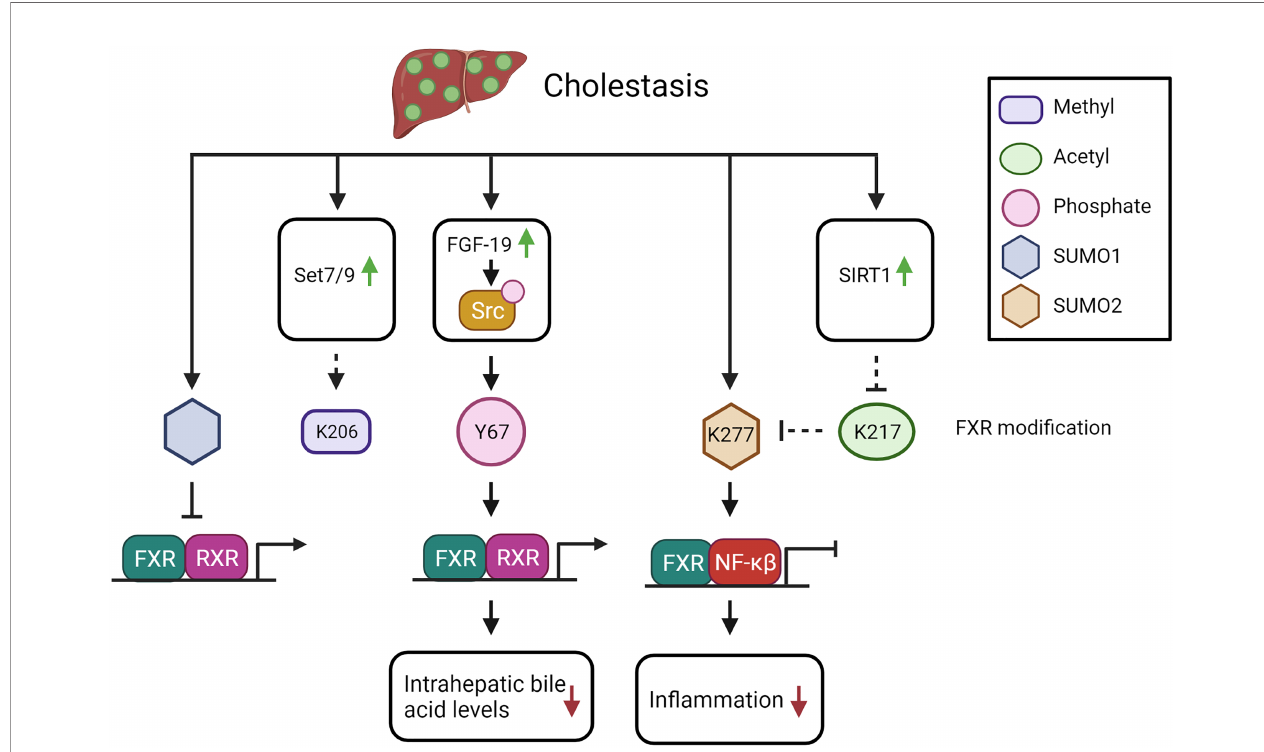
FIGURE 2 | The potential impact of FXR PTMs in cholestasis (see text for explanation). Solid arrows indicate demonstrated relations or interactions, dashed lines indicate predictions inferred from the described molecular